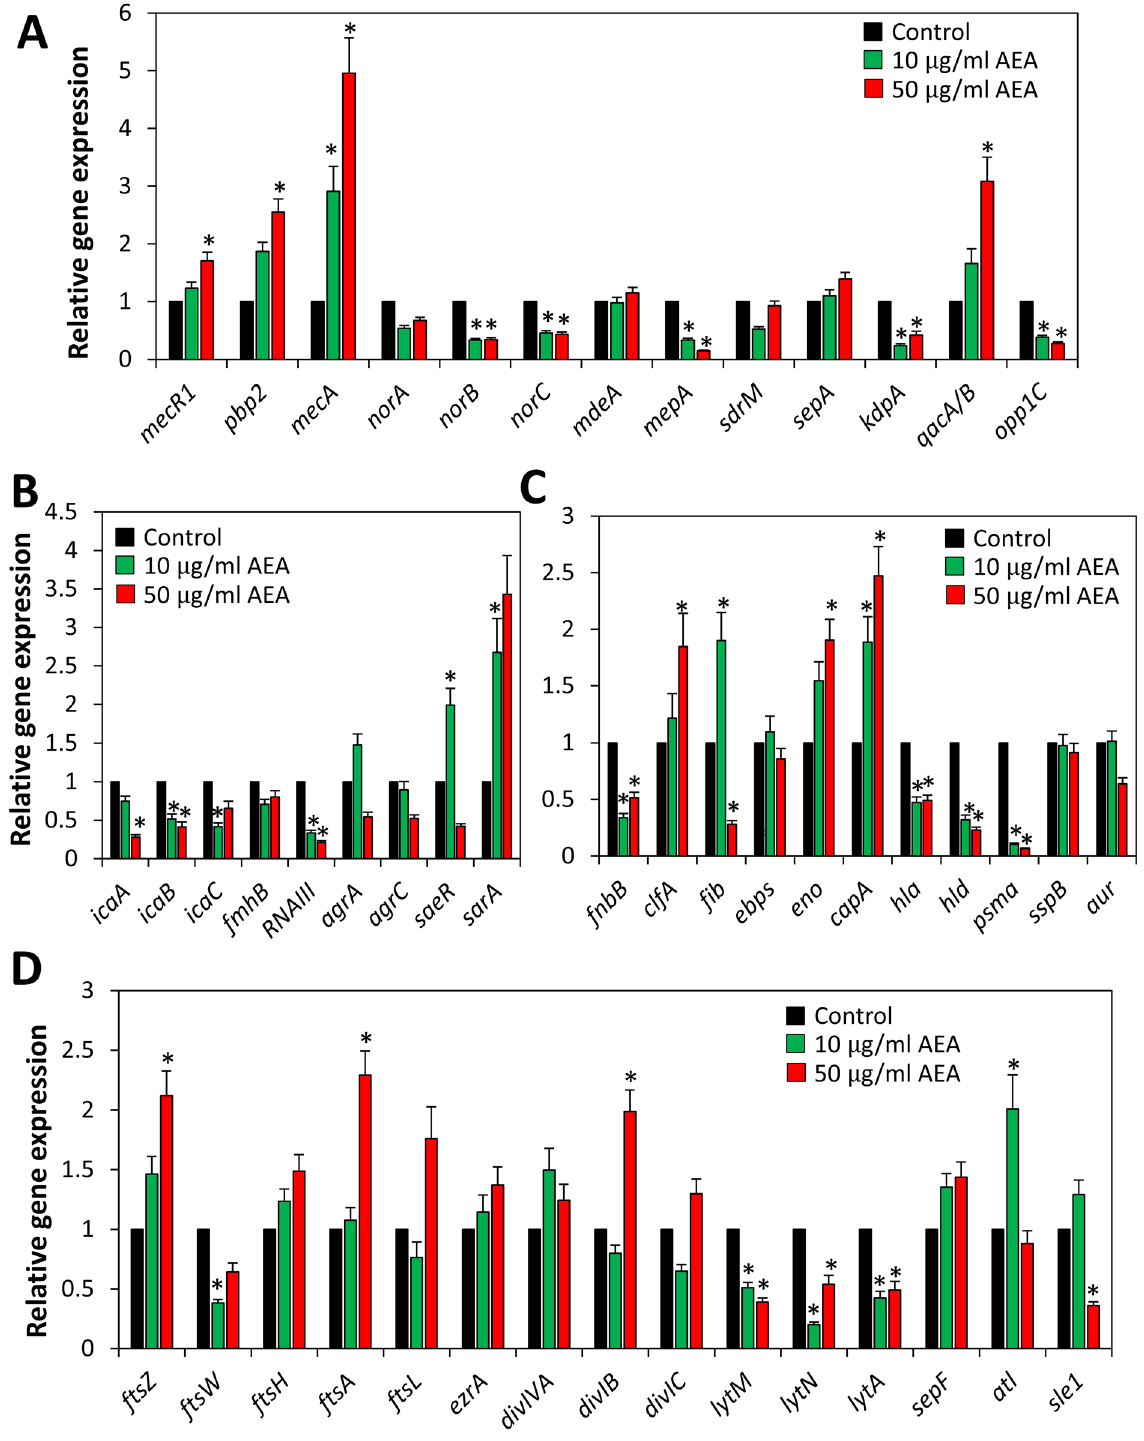
Figure 7. Real-time qPCR gene analysis of MDRSA CI-M that has been treated with AEA for 4 h in comparison to control bacteria. The graphs present the average fold-change as calculated against the seven house-keeping genes gyrB , glyA , gmk , proC , recF , rho and RNAII . ( A ) Genes related to antibiotic resistance including efflux pumps. ( B ) Regulatory and biofilm-related genes. ( C ) Virulence genes. ( D ) Genes related to cell division. *p <